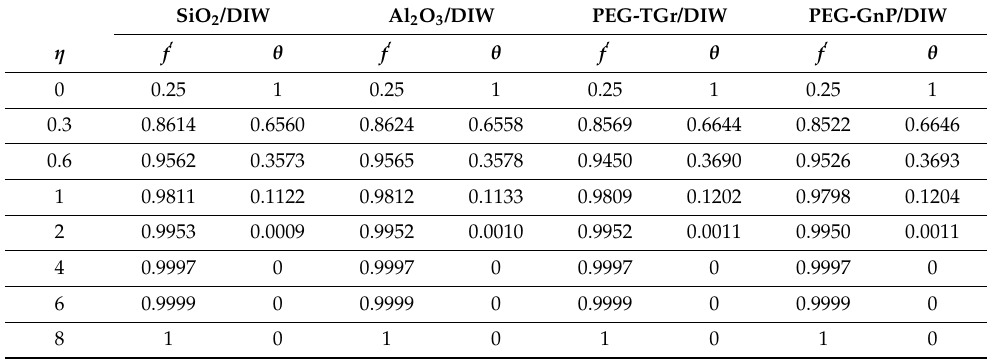
Table 7. Numeric values of velocity and temperature distribution at φ = 0.025%.